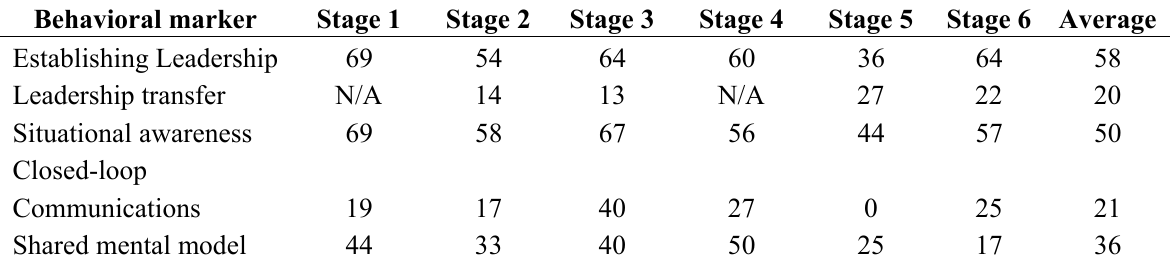
Table 7. Proportion of “excellent” behavioral markers by stage (%)